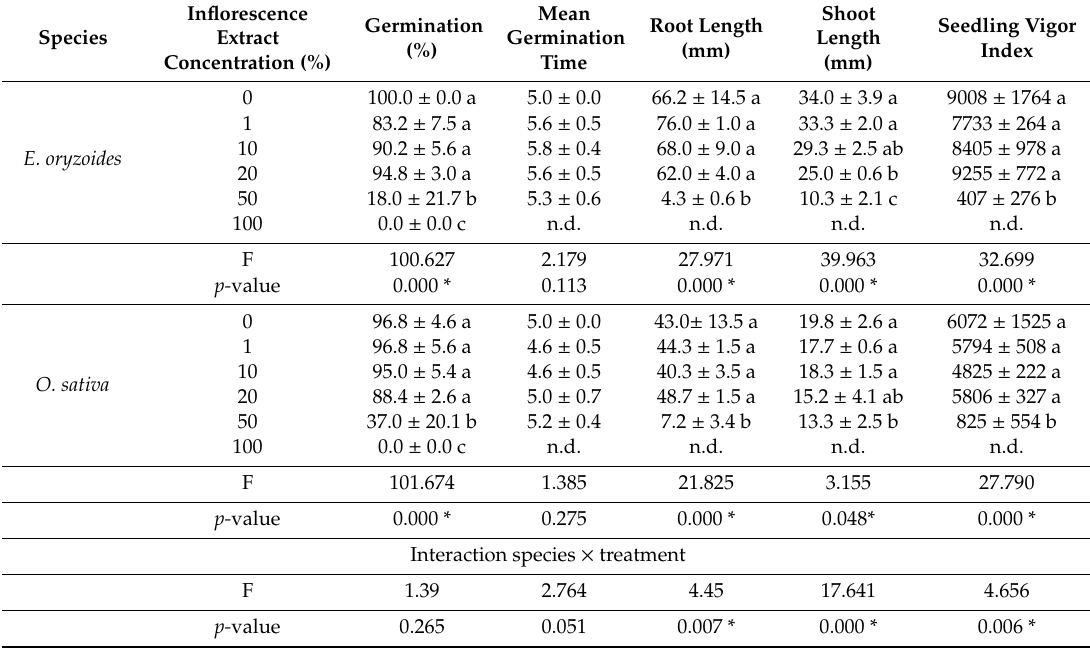
Table 3. Germination indices measured for E. oryzoides and O. sativa under the e ff ect of di ff erent concentrations of L. multiflorum inflorescence extract.